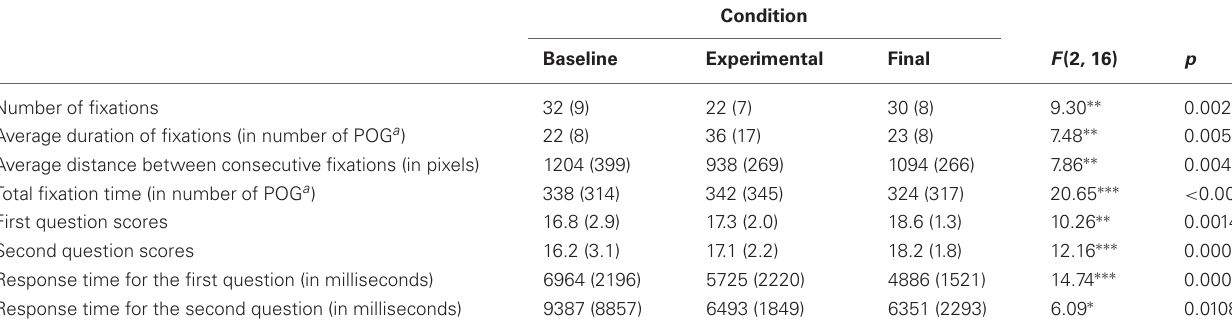
Table 2 | Means and standard deviations of dependant variables in the three sequential